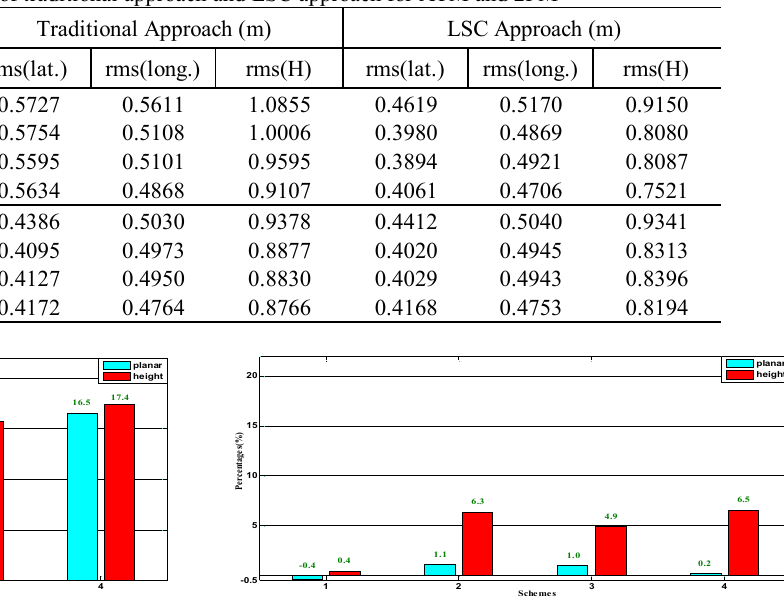
Fig. 2. Improved percentage of LSC approach based on ATM Fig. 3. Improved percentage of LSC approach based on